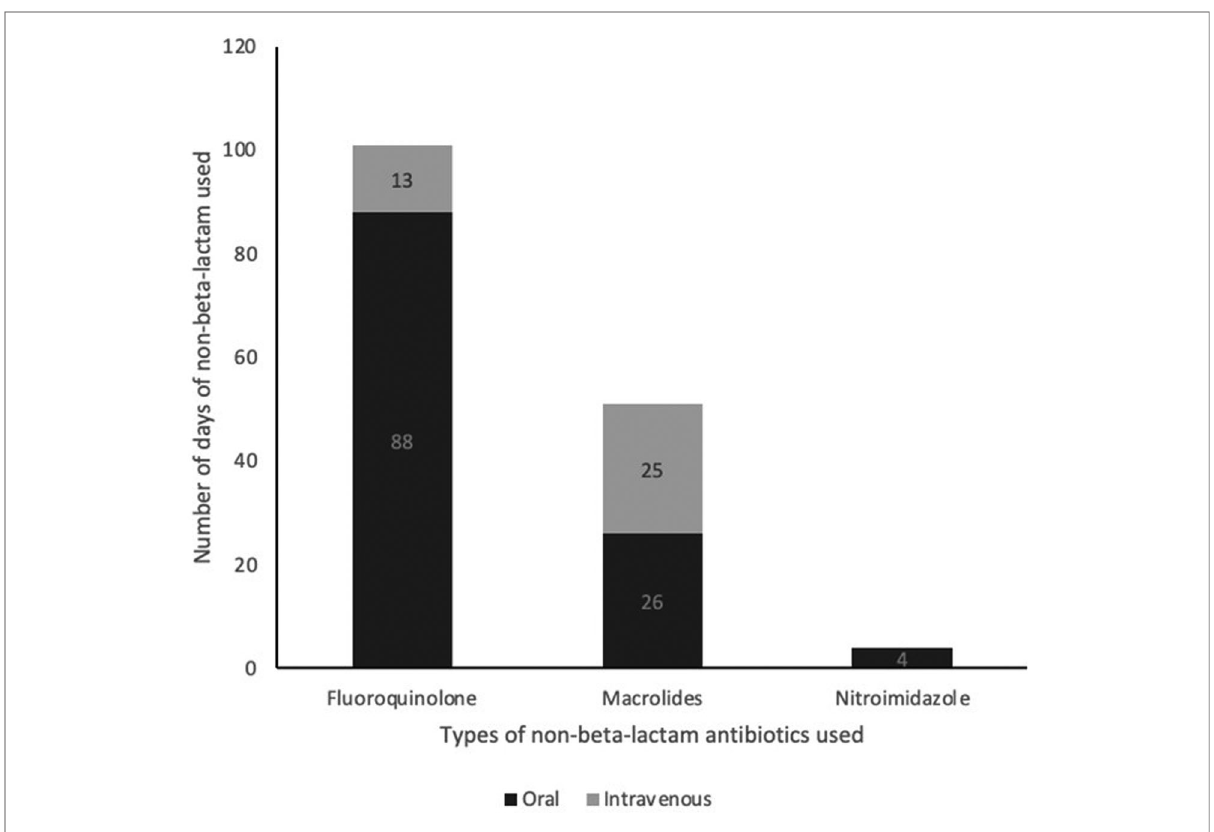
FIGURE 1 Total number of days of non-beta-lactam antibiotics used by HAE patients with beta-lactam allergy